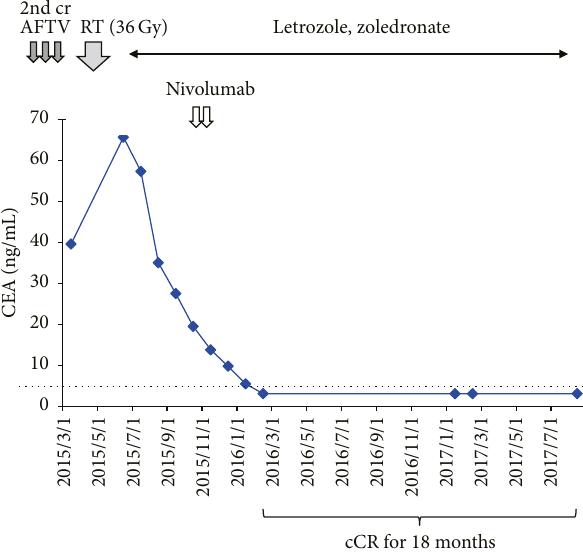
Figure 4: Alteration of blood CEA level of Case #17 after compre- hensive treatments including AFTV. 2nd cr AFTV, 2nd course of AFTV treatment; RT, radiation therapy. Dotted line indicates basal level of blood CEA in normal